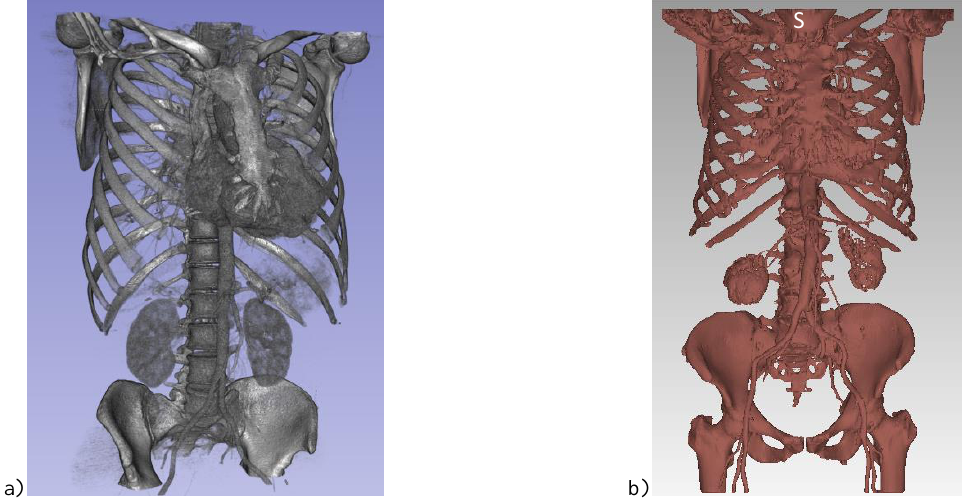
Figure 4. Example of volume rendering (a) and (b) surface mesh